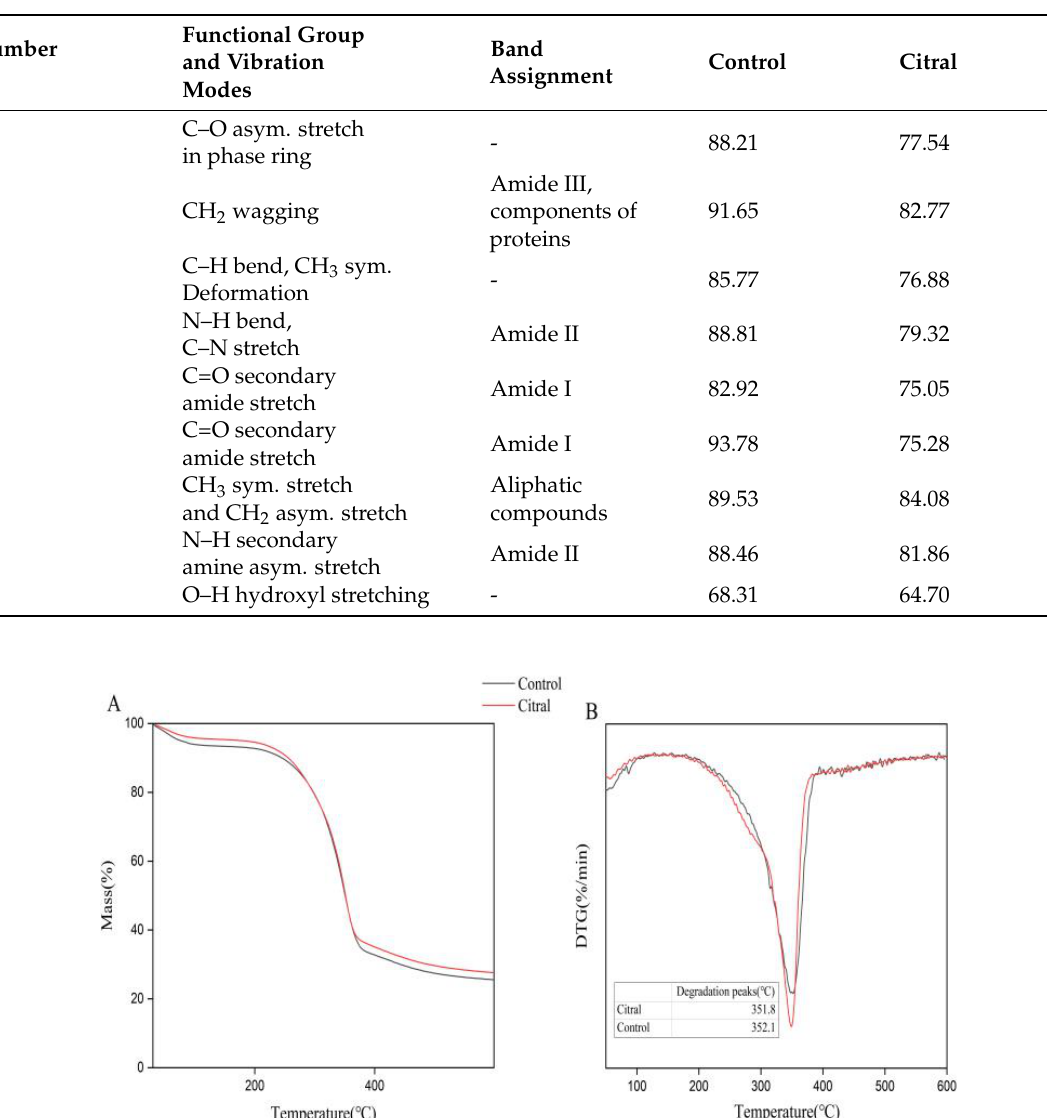
with citral and control insects.